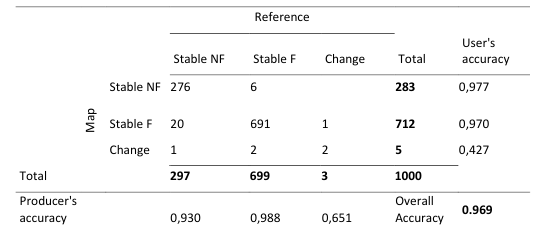
Table 1. Error Matrix of a Forest (F), Non-Forest (NF) and Change